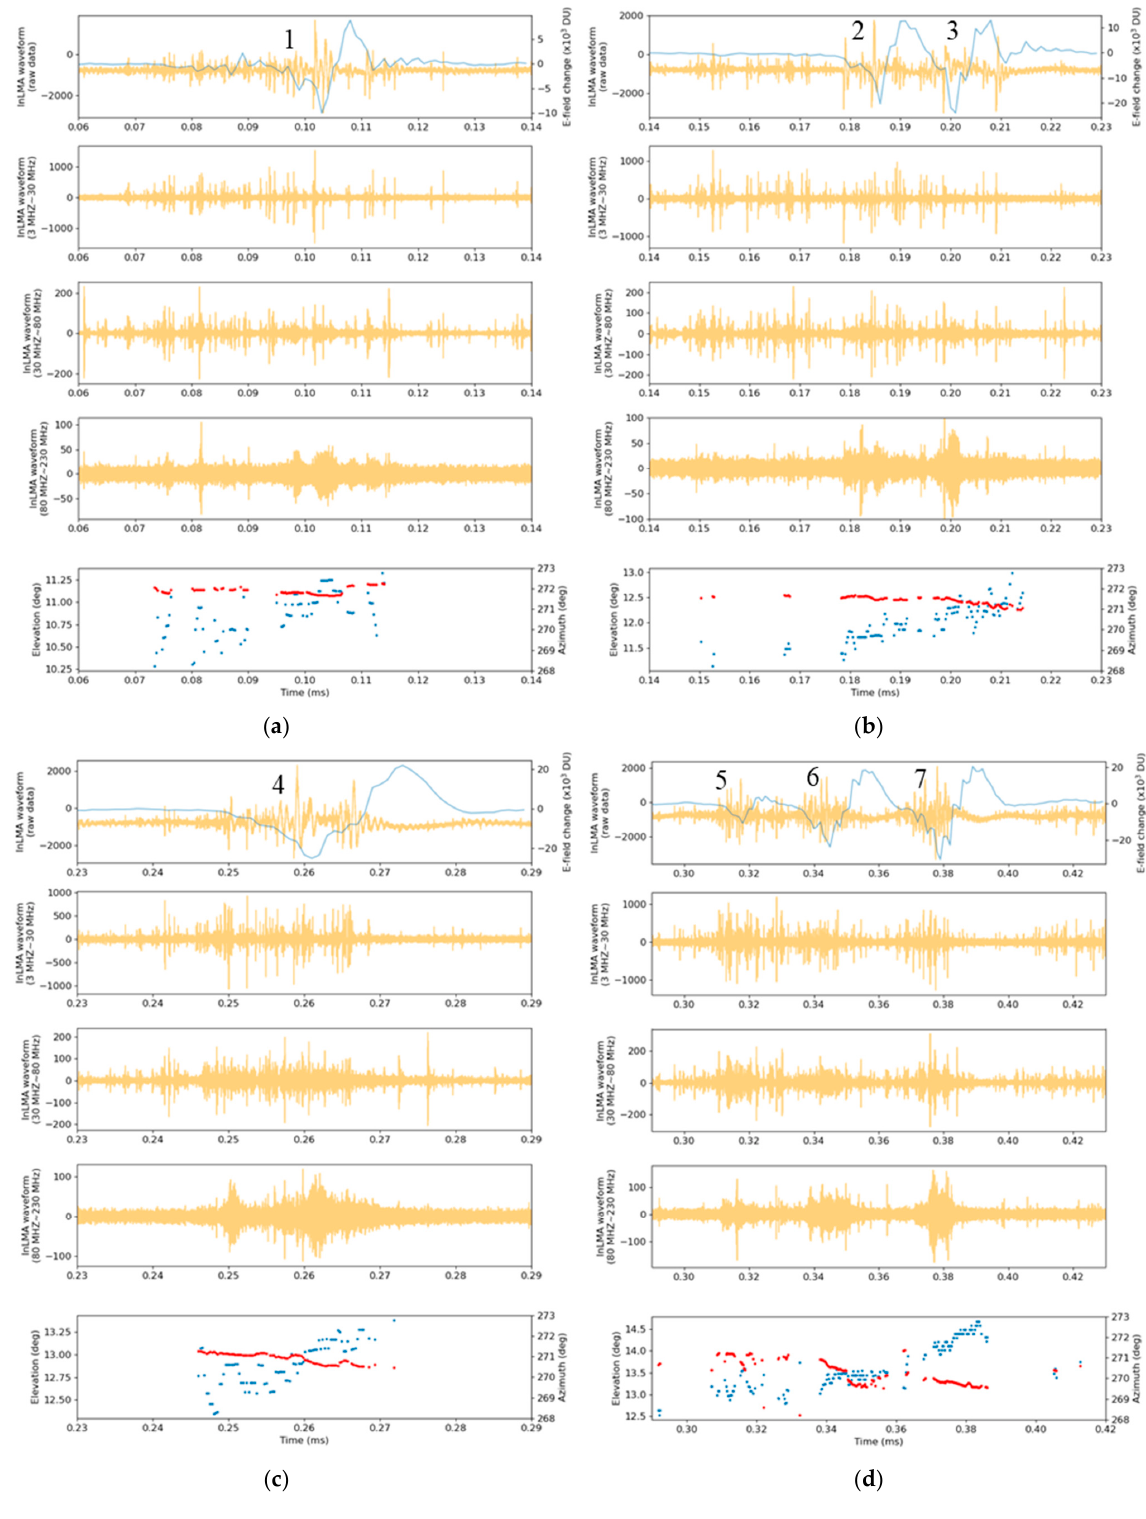
Figure 12. The raw InLMA data (top panel in orange), the 3 MHz~30 MHz, 30 MHz~80 MHz, and 80 MHz~230 MHz bandpass data (the second, the third, and the fourth panels), and the correspond- ing azimuth and elevation (the fifth or the bottom panel in red and blue, respectively) along with the E-field change (top panel in blue) with ( a ) for pulse 1, ( b ) for pulses 2 and 3, ( c ) for pulse 4, and ( d ) for pulses 5, 6, and